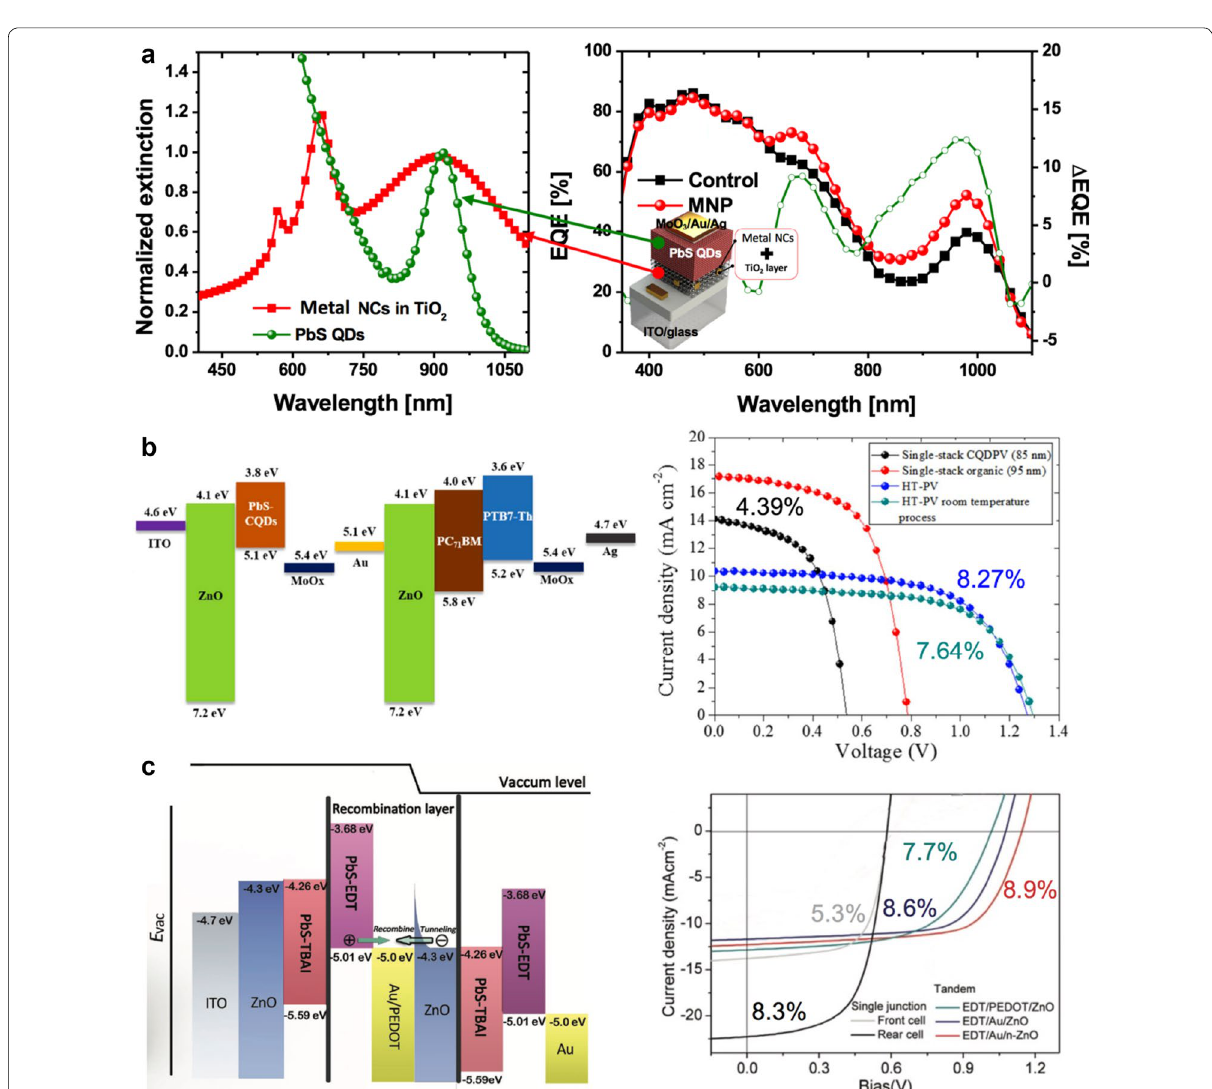
Fig. 5 a Absorption spectra of metal nanoparticles in TiO 2 and PbS CQDs; EQE spectra with and without metal nanoparticles (reprinted with permission from ref. 26, Copyright 2015 Wiley–VCH Verlag GmbH & Co. KGaA). b Energy band diagram and J–V curves of multi-junction PVs using an organic PV and a CQD PV (reprinted with permission from ref. 27, Copyright 2016 Elsevier B.V.). c Energy band diagram and J–V curves of multi- junction PVs using CQD PVs (reprinted with permission from ref. 28, Copyright 2017 Wiley–VCH Verlag GmbH & Co.